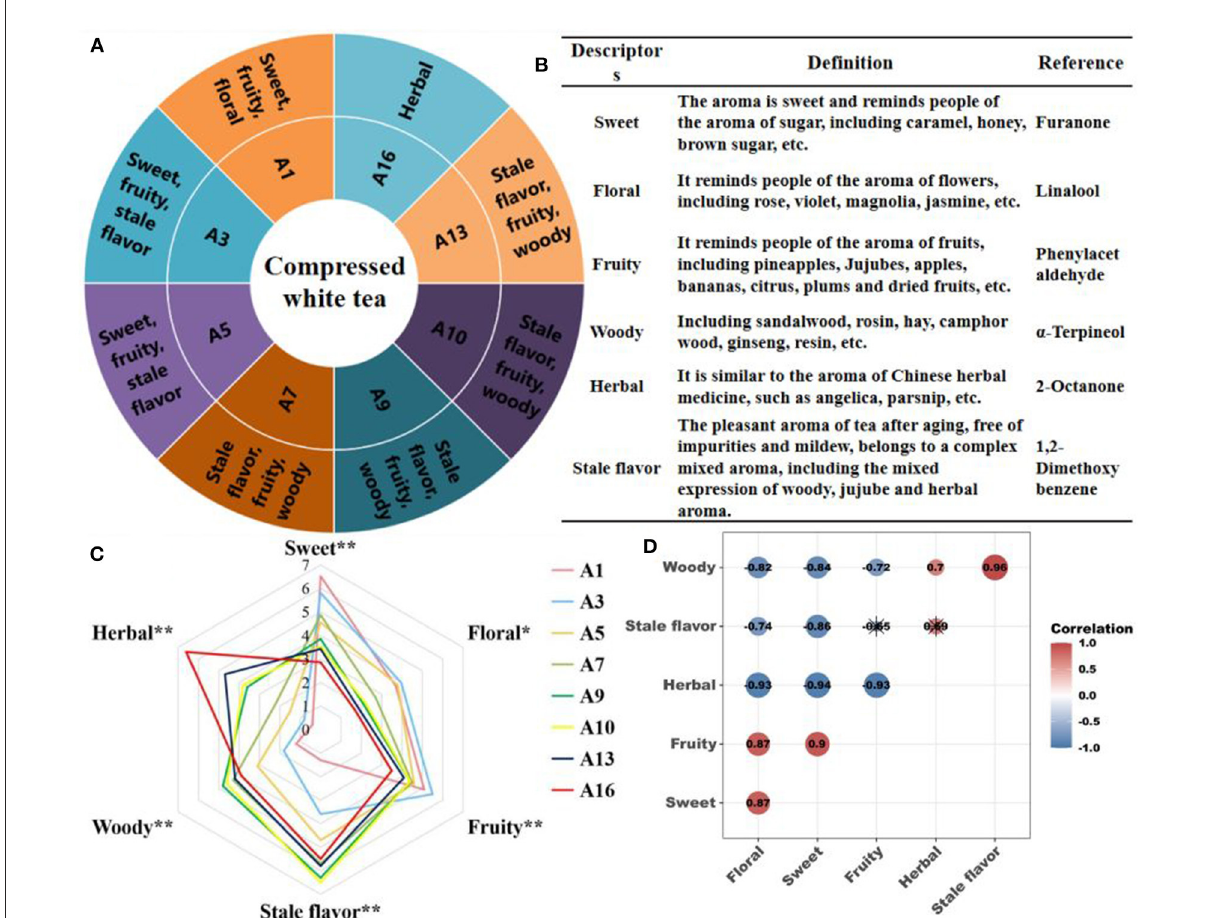
FIGURE2 Sensory aroma characteristics of CWT. (A) Flavor wheel during storage of CWT. (B) Definition and reference of aroma descriptors. (C) Quantitative evaluation of aroma sub-attributes, * P < 0.05; ** P < 0.01. (D) The intensity of the aroma sub-attribute correlation analysis, red and blue indicated positive and negative correlations, respectively. * meant that the difference was not significant ( P >